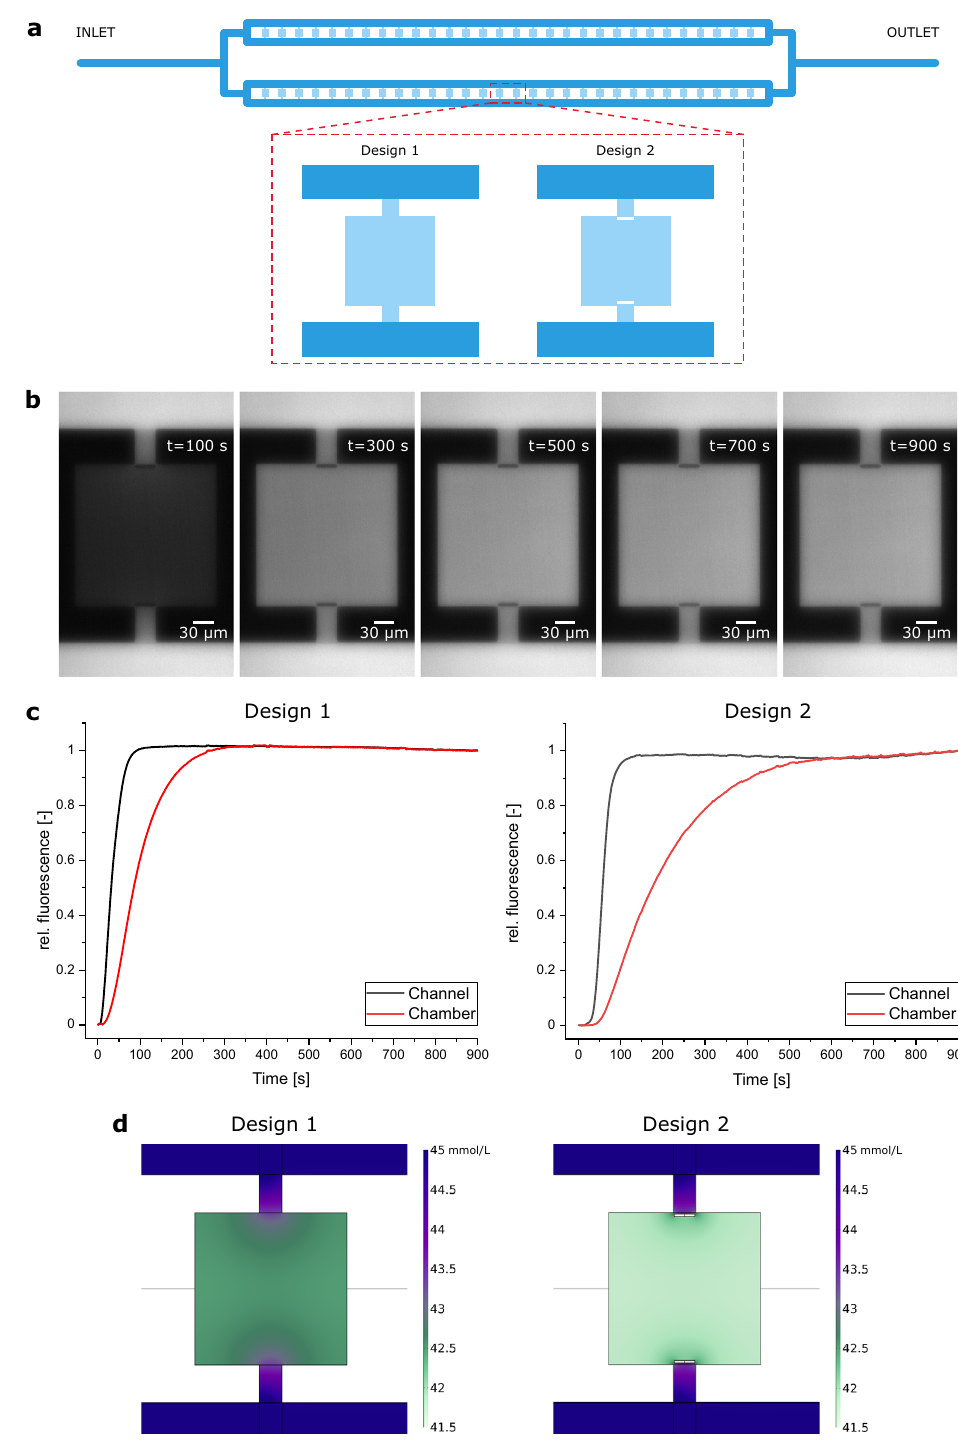
Figure 2. Microfluidic characterization of the MSCC designs. ( a ) Individual cultivation array that contains 60 cultivation chambers with either our previous chamber design (Design 1) 13 or the chamber design from this work (Design 2). ( b ) Image sequence of trace substance experiments to quantify diffusive mass exchange for the MSCC device with Design 2. ( c ) Medium exchange duration until full equilibrium between channel and chamber is achieved based on rel. fluorescein signal for both designs. ( d ) Glucose concentration profile during MSCC cultivation assuming a steady state with 181 cells inside the chamber with a constant glucose uptake rate of 3800 nmol per 10 6 cells and day for both